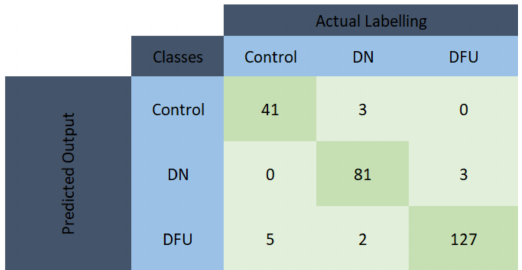
Figure 5. Confusion matrix for KNN model using the top 12 features extracted from GL and VL muscles EMG and feature ranked using the chi-square feature ranking technique.